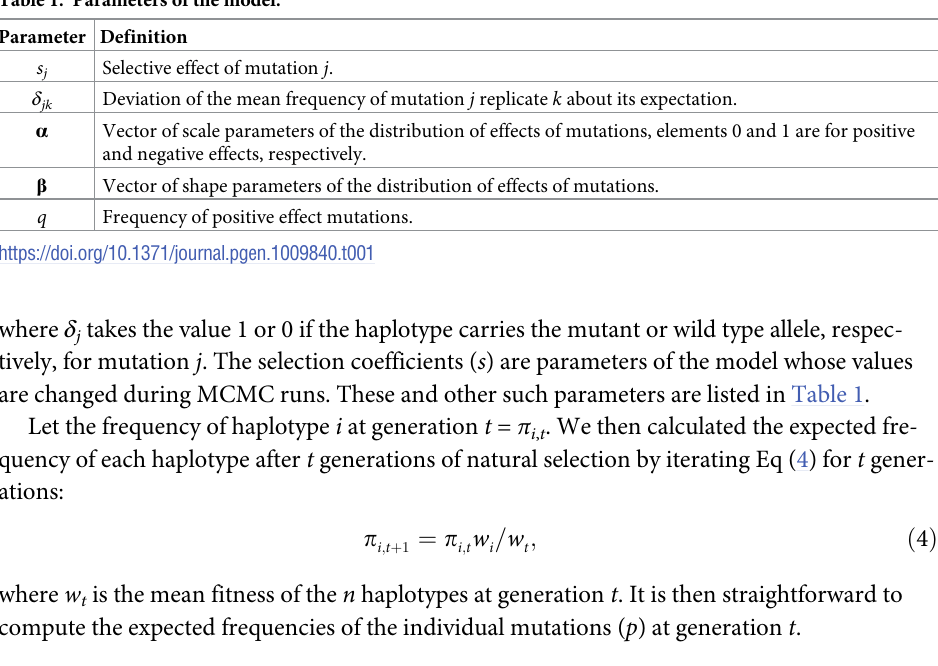
Table 1. Parameters of the